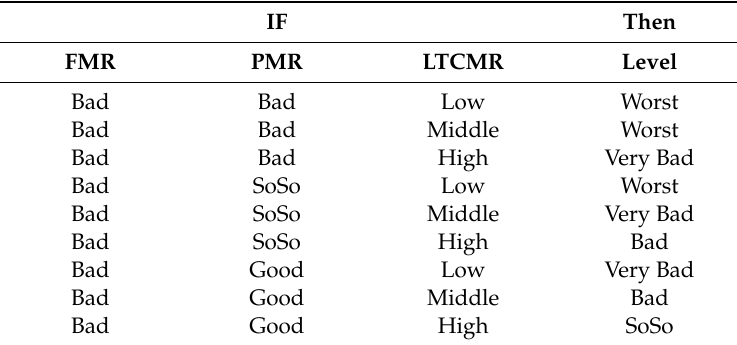
Table 5. Some part of Level